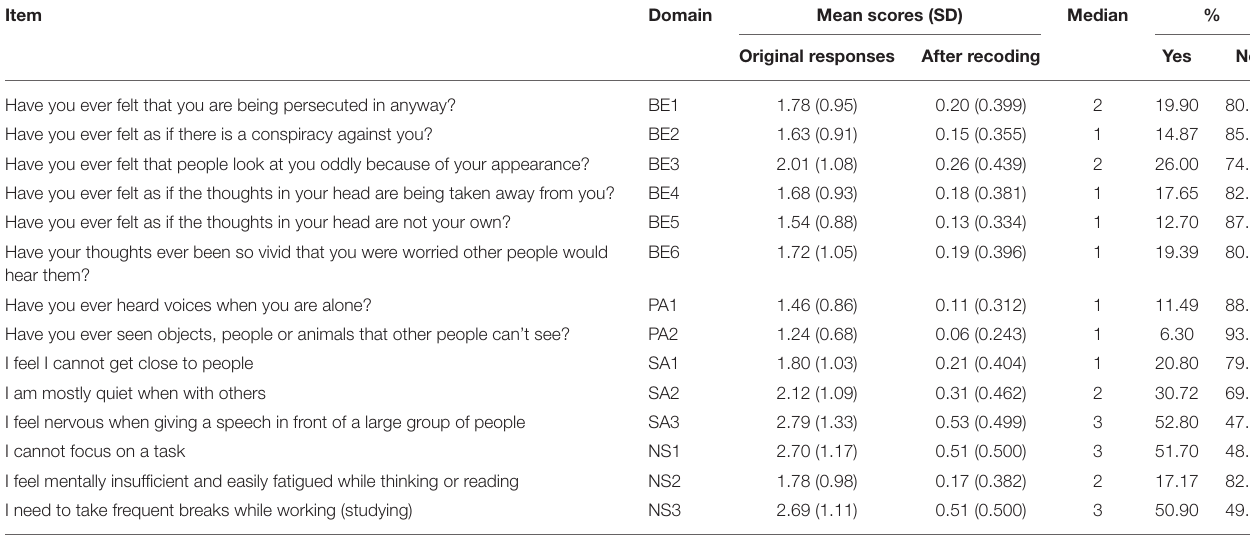
TABLE 3 | Descriptive scores of psychotic experiences (raw and dichotomized scores).